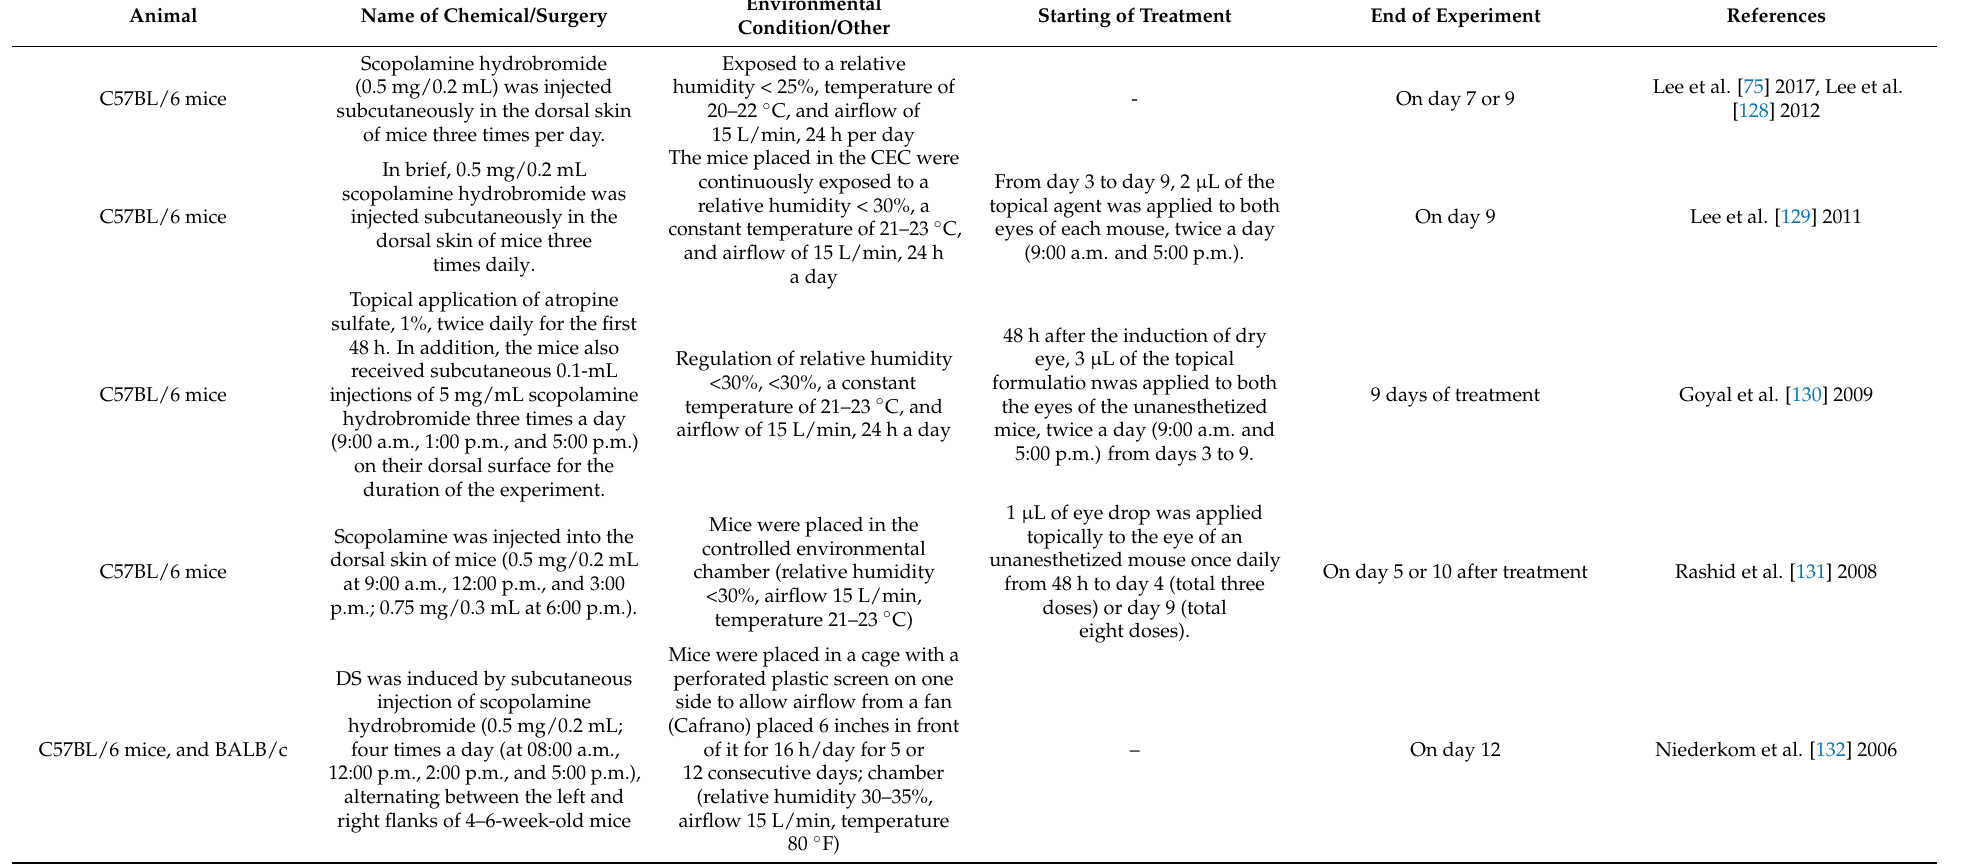
Table 7. Application of combined methods and experimental schedule in DED